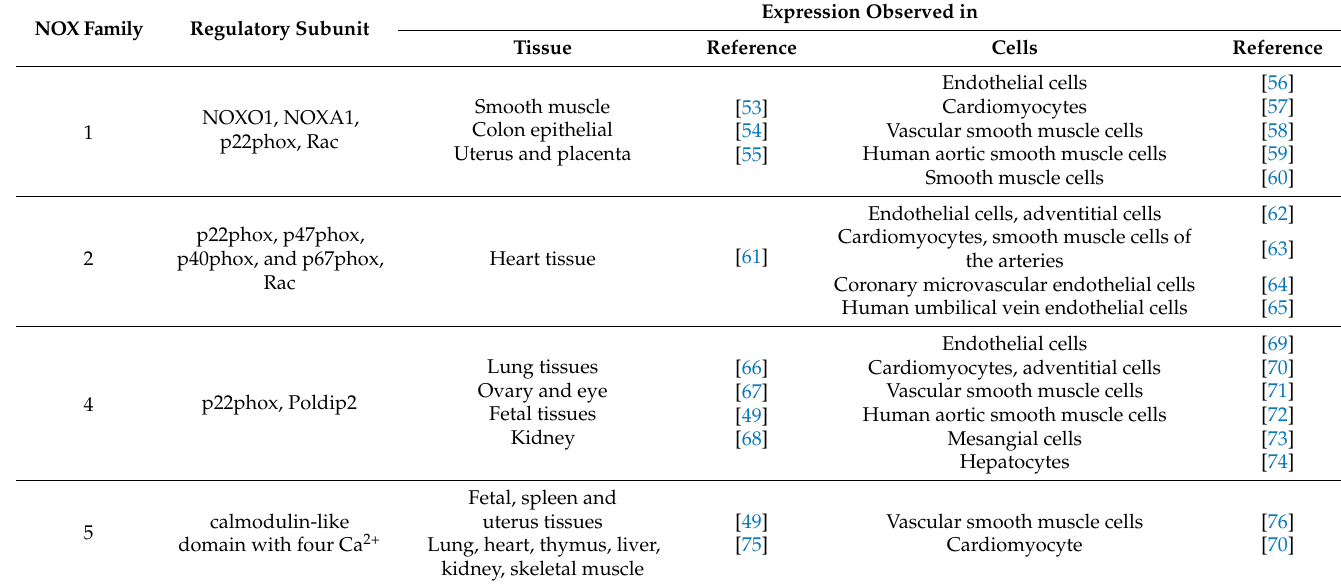
Table 1. NOX family and its regulatory subunit and expression in various tissues or